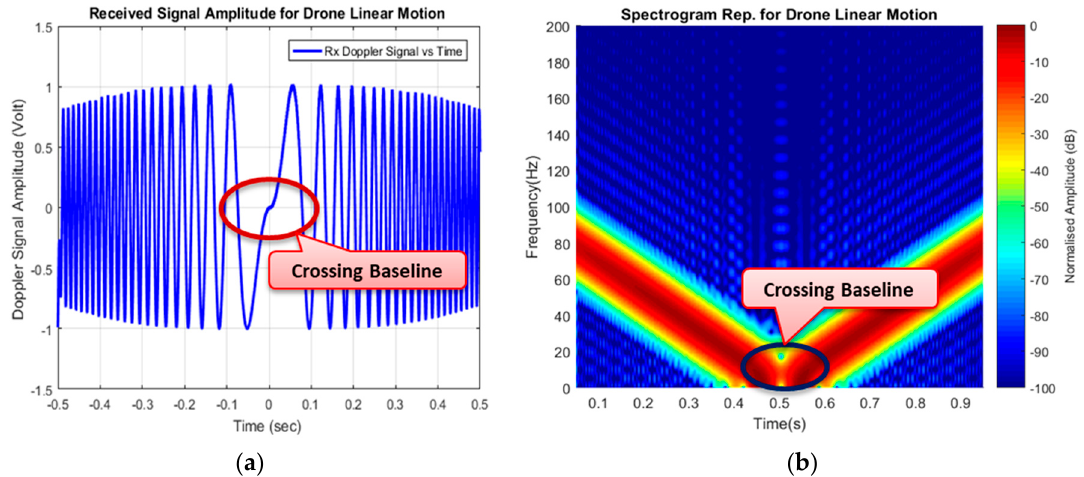
Figure 16. The Doppler due to target linear motion, ( a ) Time-domain and ( b ) Spectrogram.